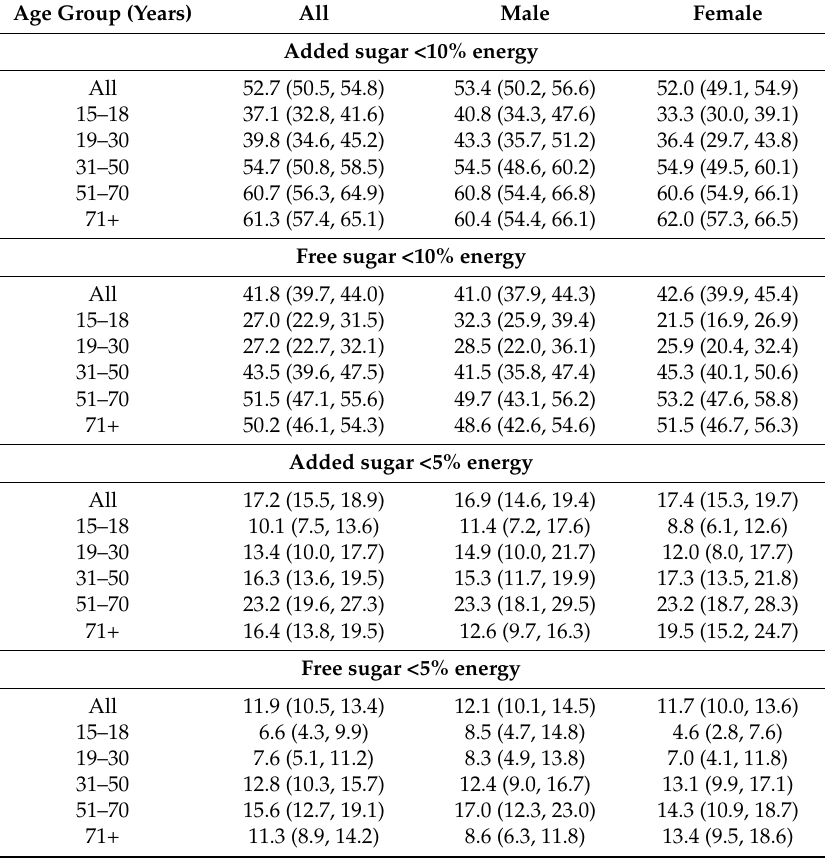
Table 3. Percentage (95% CI) of New Zealand adults aged 15 years and older in 2008/09 meeting recommendations for free sugar intakes by sex and age